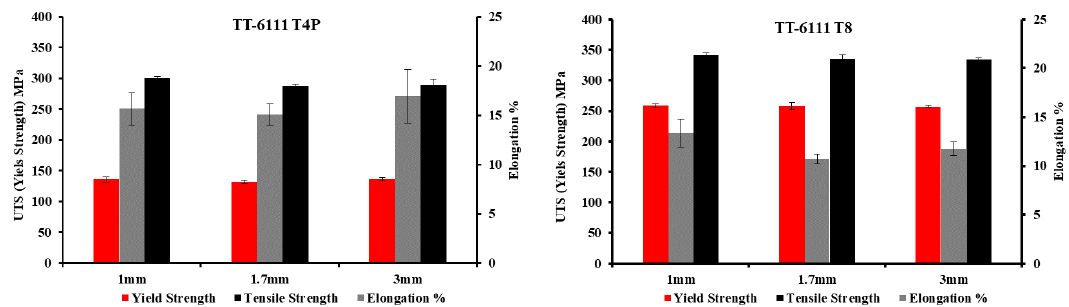
Figure 10. Tensile properties of non-homogenized TT-6111 planks, all variants, in T4P and T8 tempers. Table 2. Tensile properties of non-homogenized TT-6111 (3) planks after thermo-mechanical treatment in T4P and T8 temper for different gauge thickness in the transverse section for MC-DC castings.